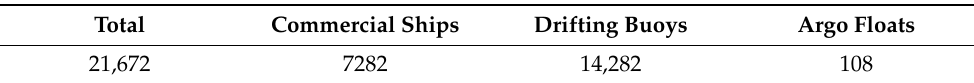
Table 1. Number of bulk-skin SST data pairs obtained from the iQuam database from July 2015 to May 2022.